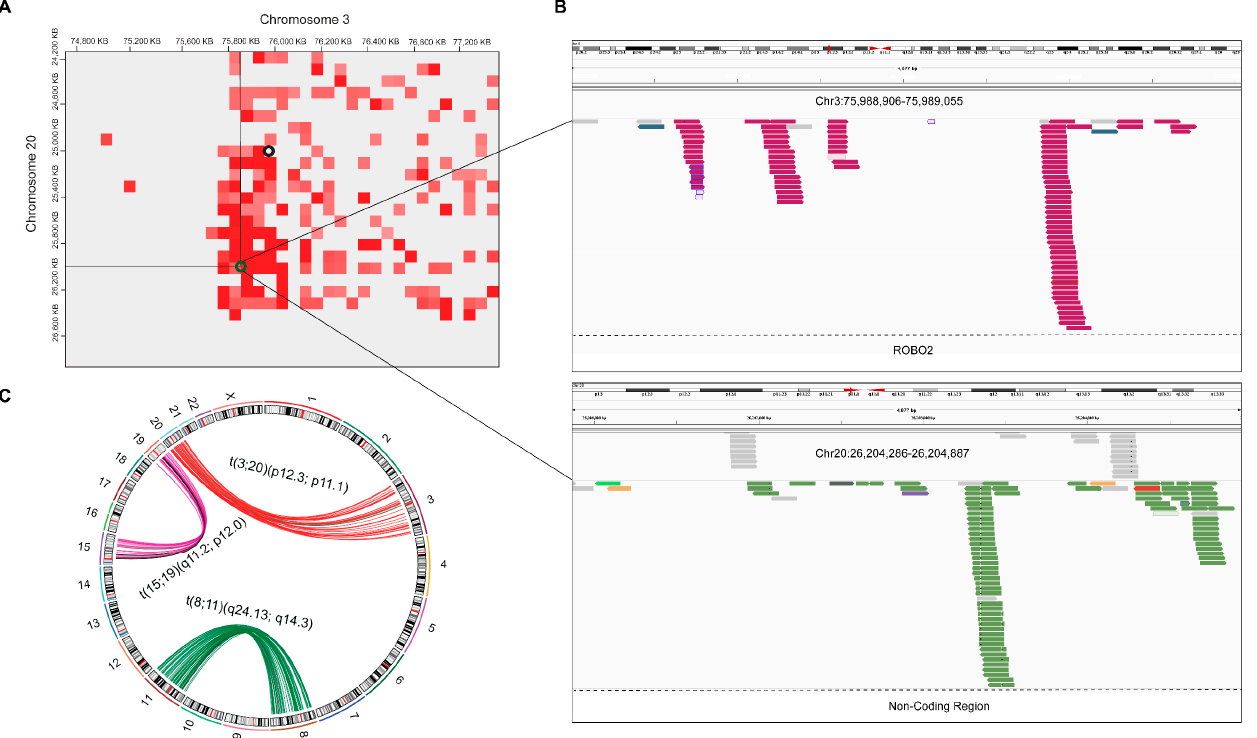
Figure 5. Cross-validation of Hi-C-based translocations with mate pairs analysis in WGS data. ( A ) breakpoints between chromosome 3 and chromosome 20, Green circle; HiC_trans, Black circle; hic_breakfinder. ( B ) In t(3;20)(p12.3;p11.1), mate pairs are shown in upper and lower panel with deep pink and light-green color, respectively. ( C ) In circos plot, translocations detected by Manta in each chromosomal pair are shown with red, purple, and green. Hi-C overlapped results were highlighted with black arcs.